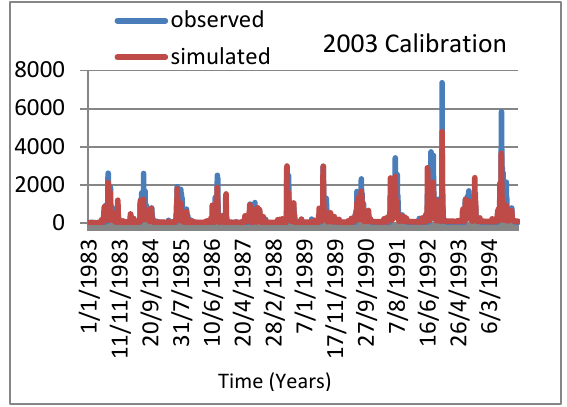
Figure 15 Plot showing simulated vs observed runoff at monthly time step for the year 2018(Validation)